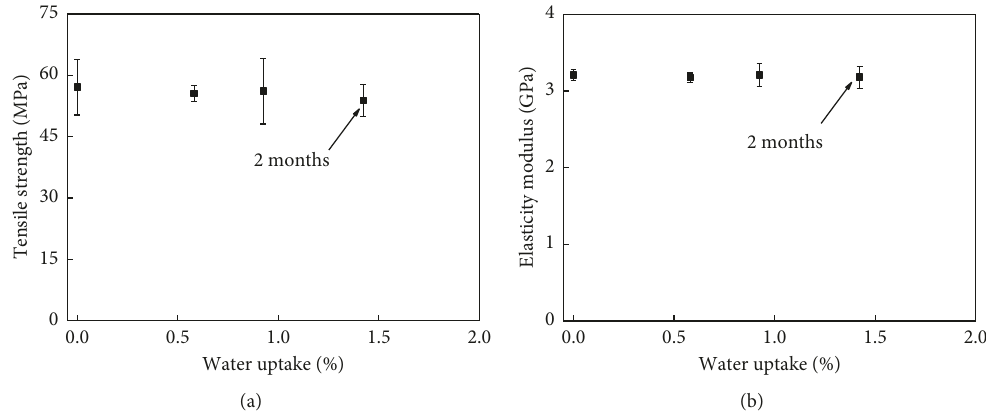
Figure 6: Effects of the water uptake on the tensile strength (a) and elastic modulus (b) of the